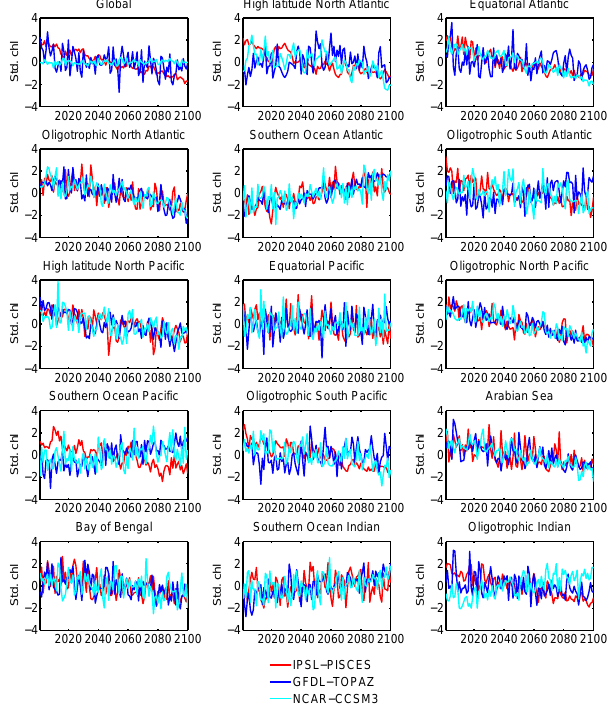
Fig. 3. Annual ocean chlorophyll concentrations projected for 2001–2100 averaged globally and in 14 biomes from three-ocean biogeochemical models forced with the A2 scenario from the Spe- cial Report on Emission Scenarios (Nakicenovic et al., 2000). The projections are standardized (the mean is subtracted from the time series and then the time series is divided by its standard deviation) to display concentrations on the same scale. The trends magnitudes are presented in Table 2.